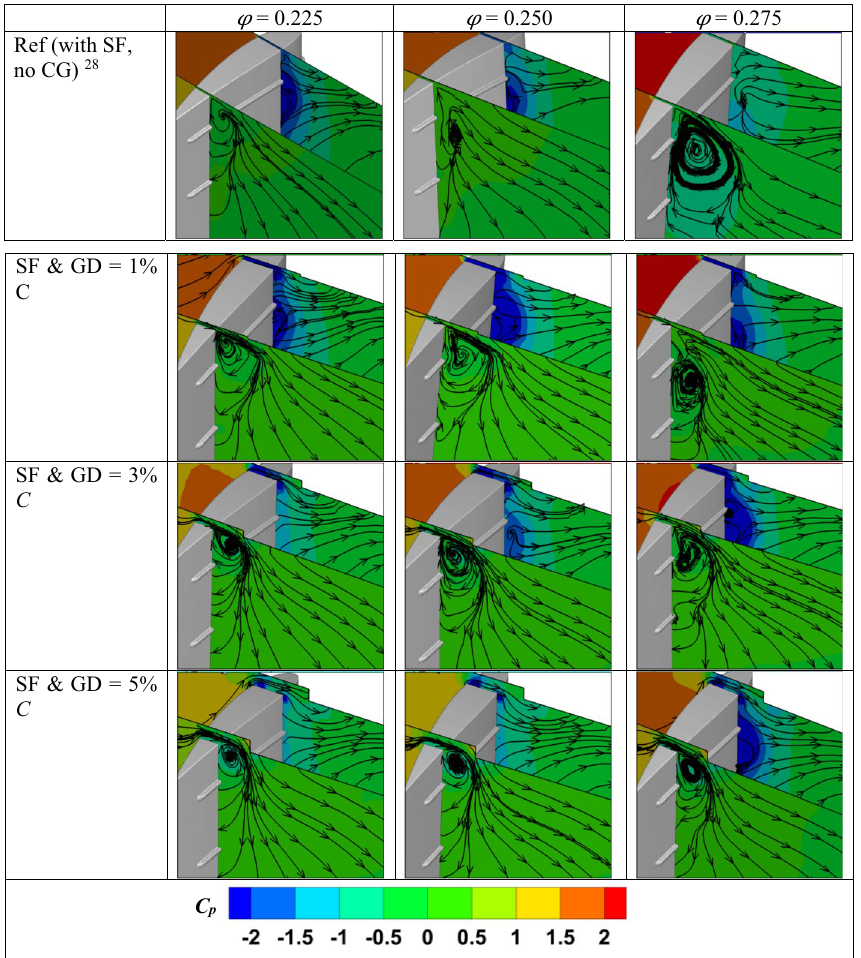
Figure 11. Streamline and pressure contours in different planes near the leading and trailing